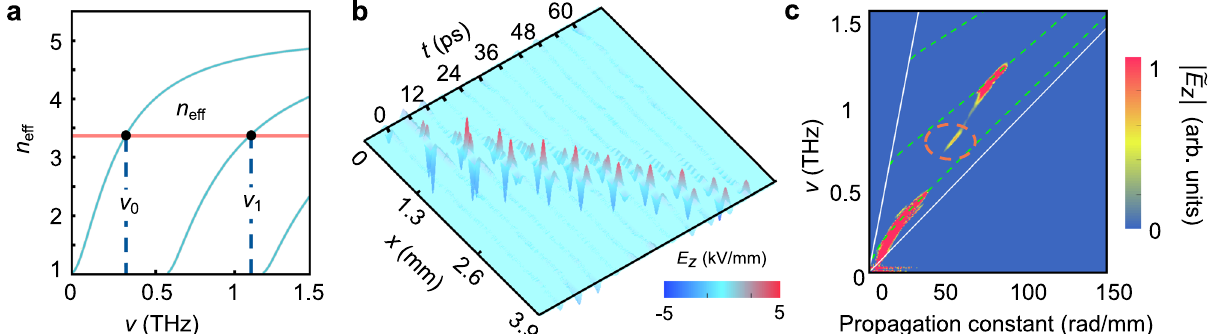
Fig. 2 Experimental results of nonlinear generation of THz waves. a Selection of velocity matching, where the zero and the fi rst order TE waveguide modes of the THz waves plotted by cyan curves are chosen to match the pump laser pulses plotted as the red line. b Experimental observations of the spatiotemporal propagation of THz waves in LN waveguide. c The dispersion relation of THz waves by performing a 2D fast Fourier transformation of b . The two white solid lines indicate the light cone in vacuum and bulk LN, the dashed green curves represent the theoretical calculation for the waveguide modes, and the color mapping shows the THz fi eld amplitude generated by the velocity matching technique, where the DFG signal is marked by a dashed